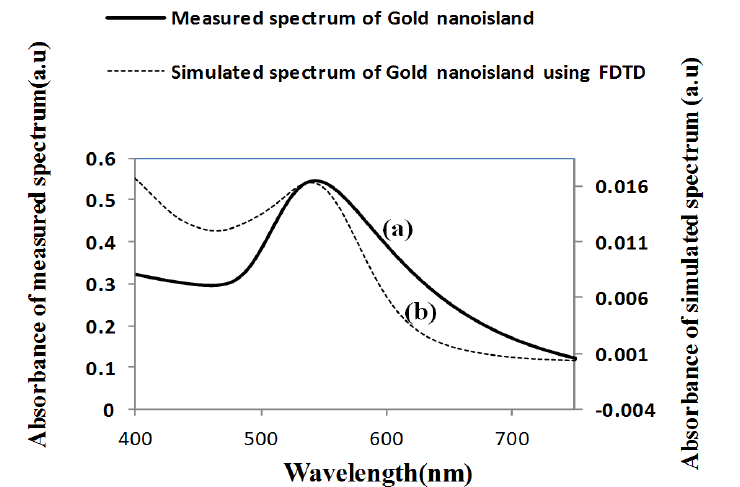
Figure 9. ( a ) Measured LSPR spectrum ( b ) simulated LSPR spectrum of the gold nano-hemisphere.